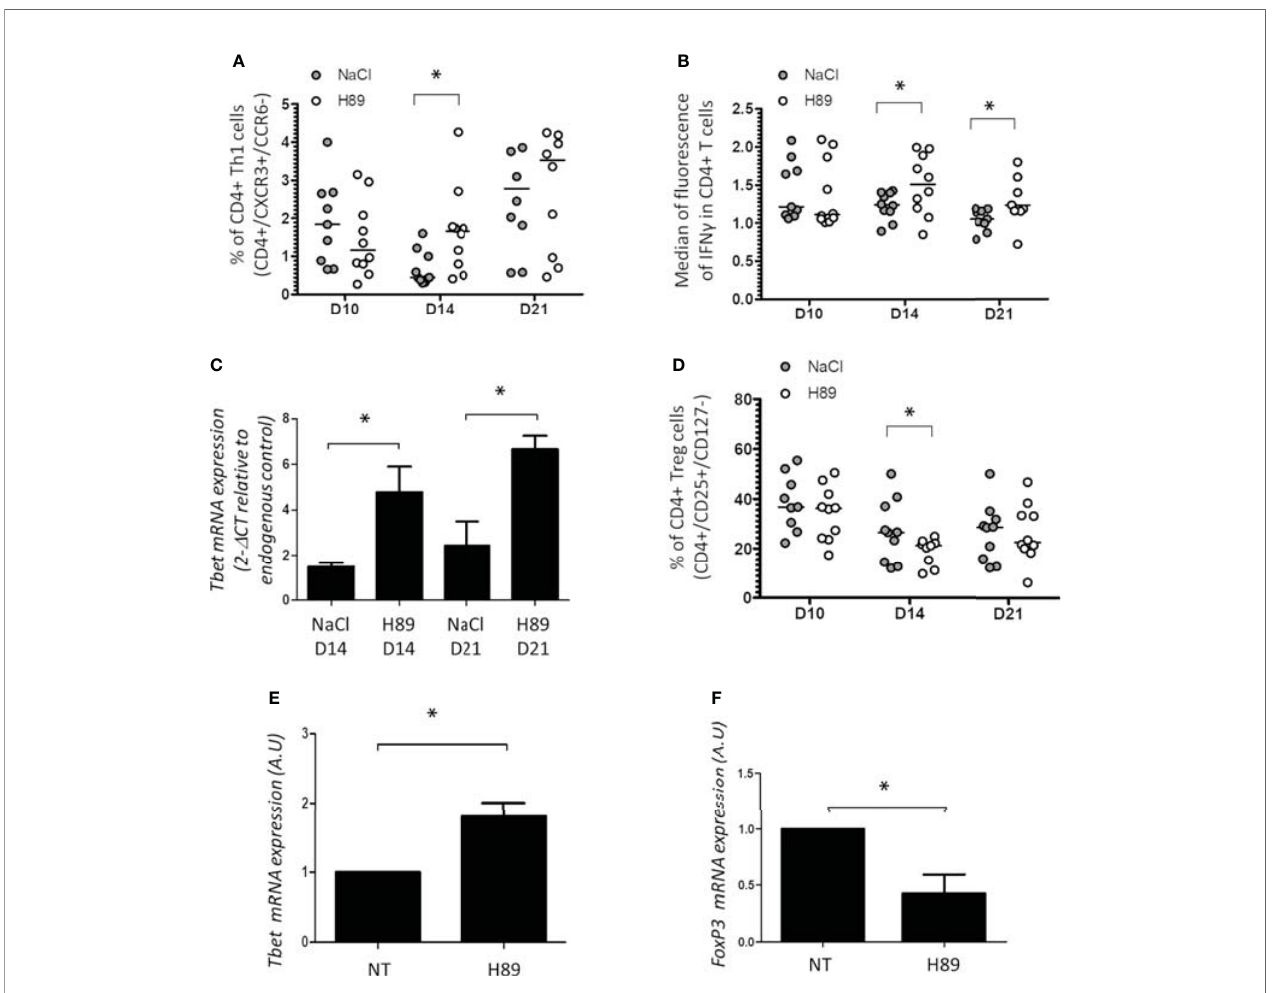
FIGURE 4 | Effect of H89 on CD4 + TL in fi ltration and differentiation. (A, B, D) Flow cytometry analysis ( n =10 mice/group) of the intratumor in fi ltration of CD4 + Th1, Treg, and IFN- g expression in CD4 + T cells on day 10 (D10), D14, and D21 after CT26 colon cancer cell injection into BALB/c mice (5 × 10 5 in s.c.), treated or not by H89 (10 mg/kg, i.p. injection two times a week). Control group received NaCl injection. (C) RT-qPCR analyses of Tbet expression at D14 and D21 after CT26 cancer cell injection into BALB/c mice ( n =3 mice). The results are presented as the mean of 2 − D CT values. (E, F) RT-qPCR analyses of Tbet and FoxP3 expression on splenic naive CD4 + T cells from BALB mice after in vitro differentiation into Th1 and Treg under H89 treatment (1 µM, 72 h) ( n = 3). The results are calculated as the mean of 2 − D CT values. Each control values (NT) are set at 1 arbitrary unit (A.U.) and H89-treated conditions are compared with control. Statistically signi fi cant differences were determined by using a t -test: * p ≤